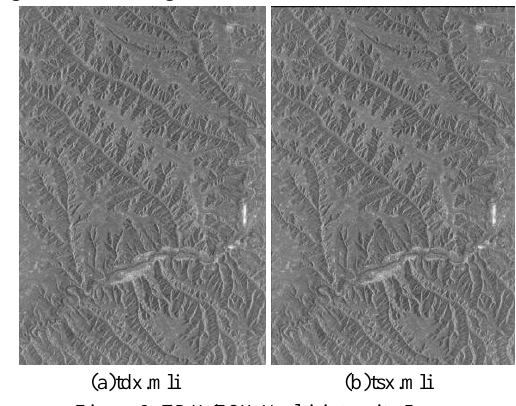
Figure 3. TDX/TSX Multi-intensity Image